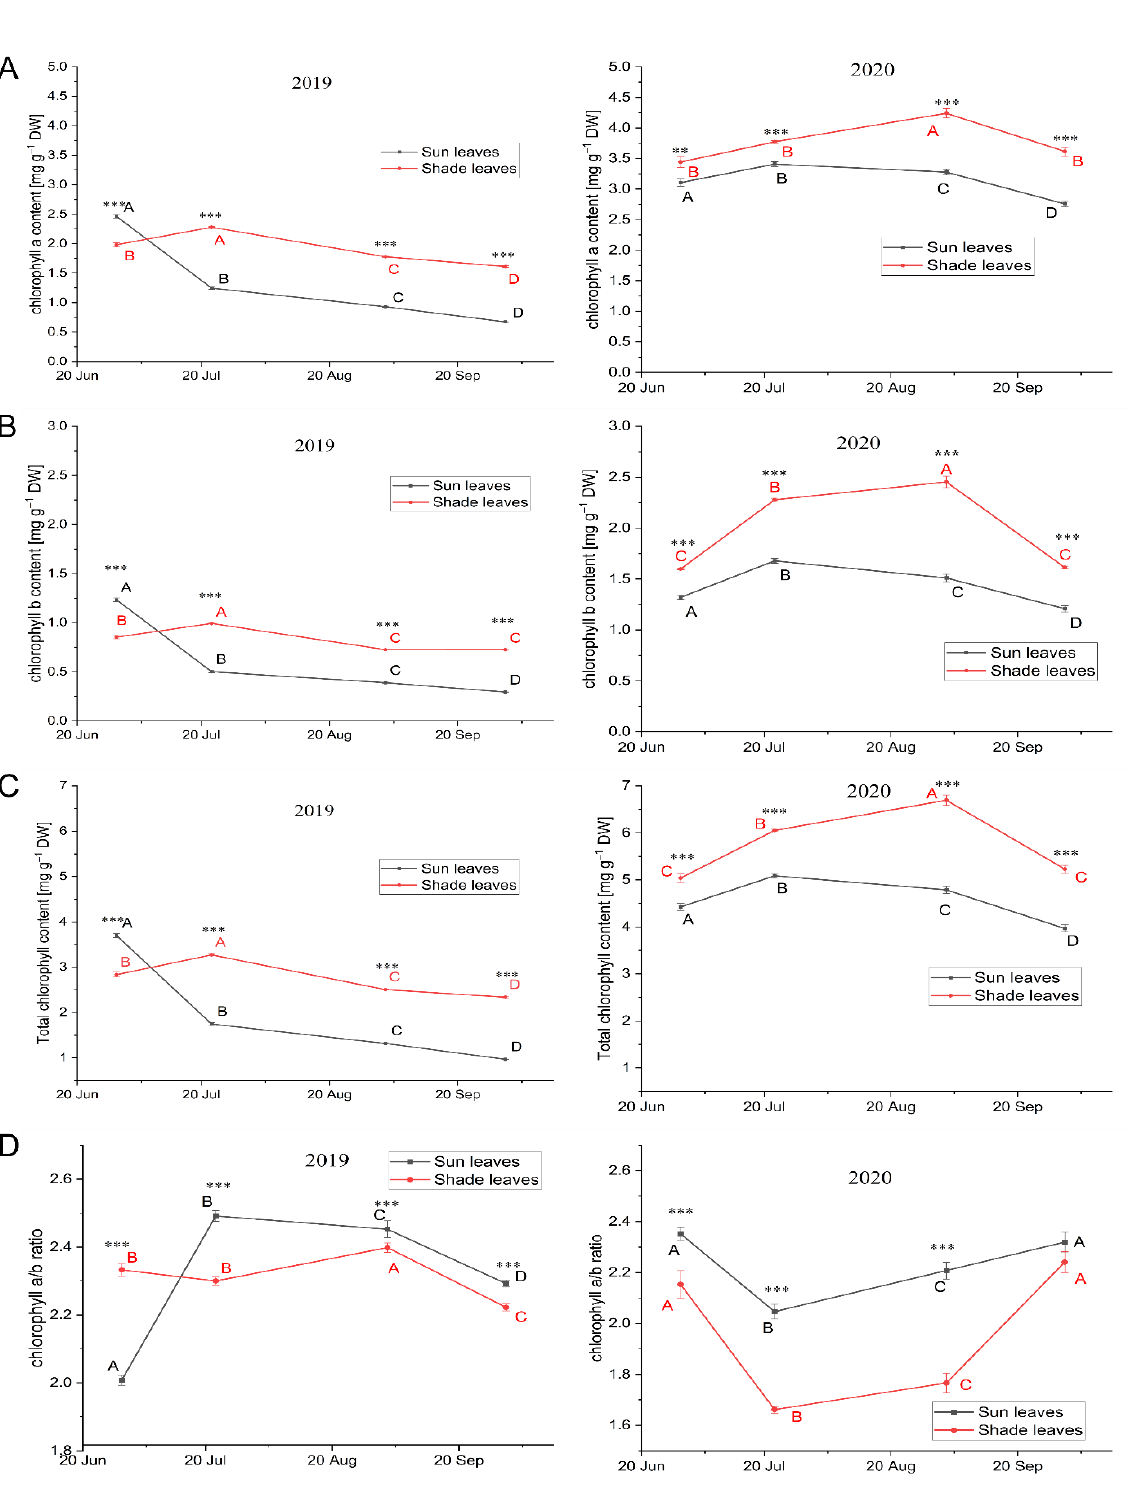
Figure 2. Changes in chlorophyll a ( A ), chlorophyll b ( B ), and total chlorophyll ( C ) contents and chlorophyll a/b ratio ( D ) in sun and shade senescing beech ( Fagus sylvatica L.) leaves. Analyses were performed for sun (black line) and shade (red line) leaves in 2019 and 2020. Each point is the mean of 60 measurements (±standard error). For each type of leaves, means with different uppercase letters differ significantly at p < 0.05. For each date, means with asterisks differ significantly at ** — p < 0.01 and *** — p < 0.001.